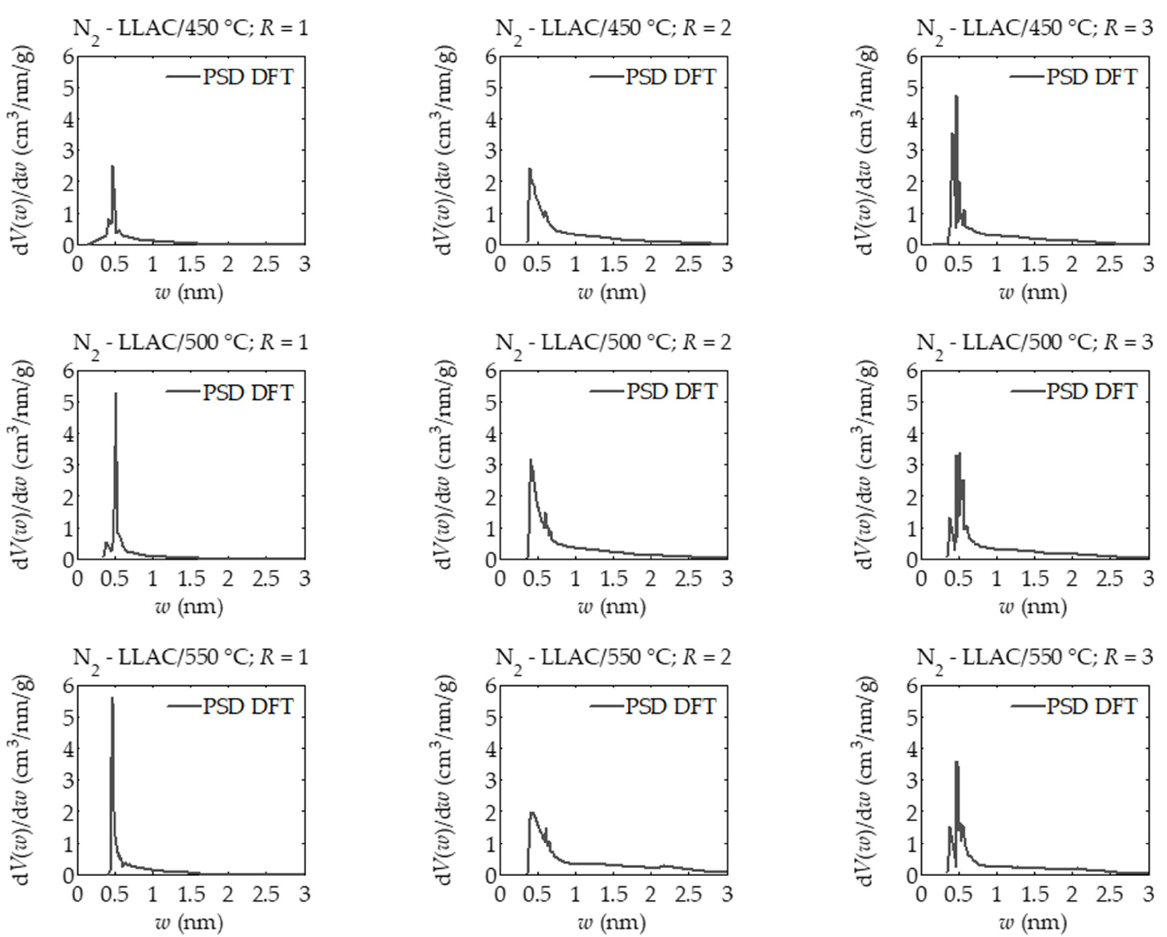
Figure 1. The pore size distributions in the range of 0 to 3 nm determined for all analyzed samples of nitrogen-doped activated carbons prepared from lotus leaves by carbonization and chemical activation with sodium amide NaNH 2 on the basis of nitrogen adsorption isotherms via the DFT